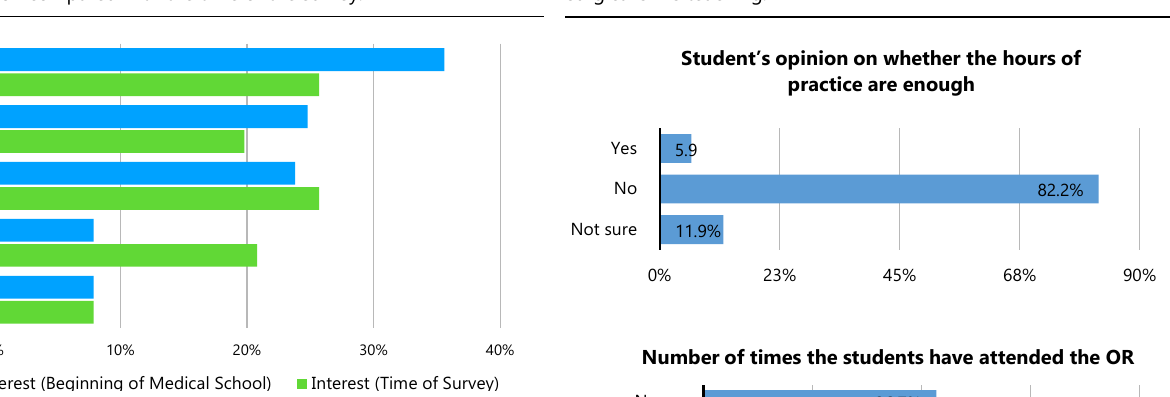
Figure 2 . Student’s experience of and ideas for improvement for surgical skills